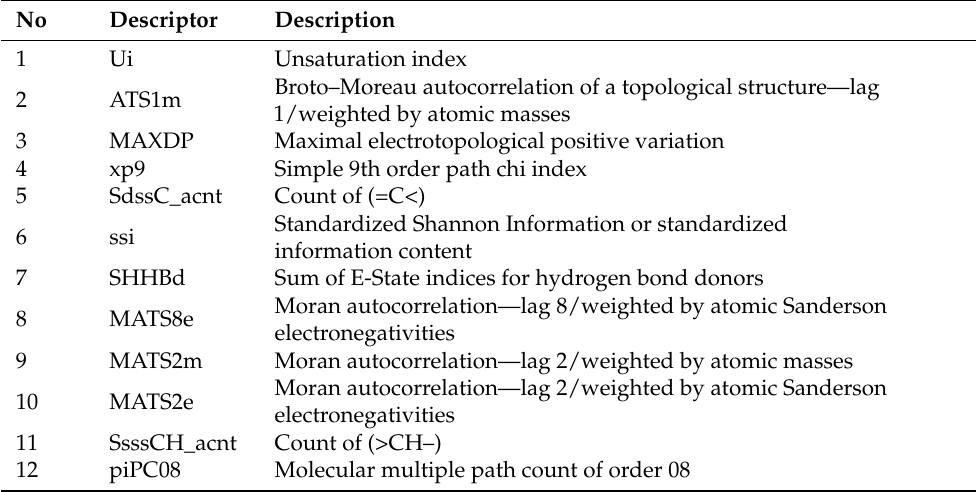
Table 1. The concept of different descriptors included in model.